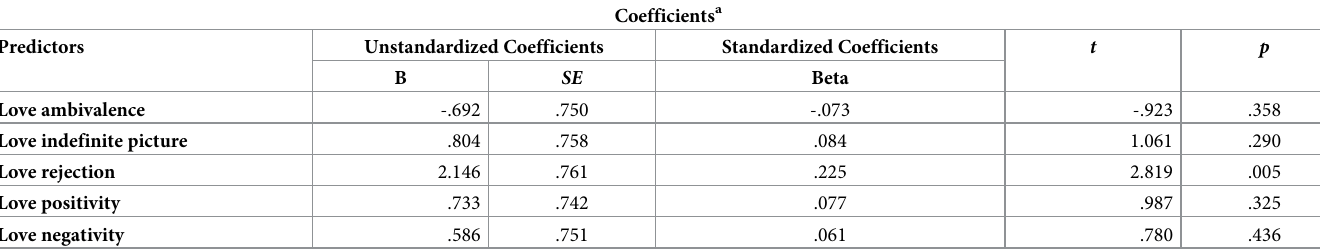
Table 7. Love script: Multiple regression analysis; script’ factors predict state anxiety.